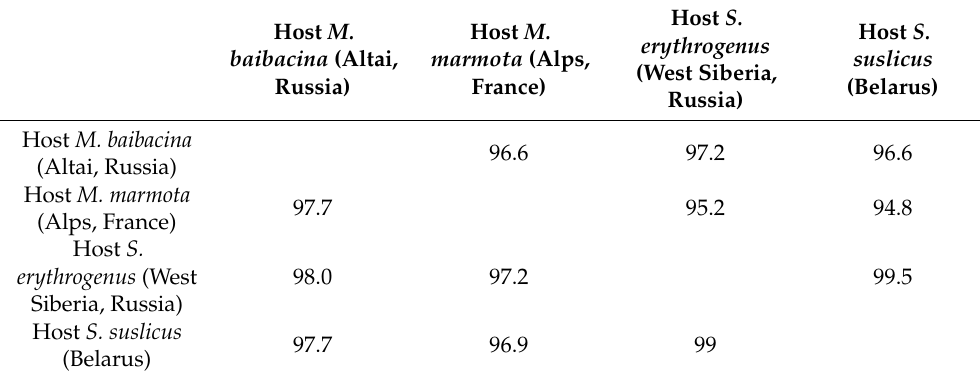
Table 3. Sequence identity rates (%) of mitochondrial genes cox1 (above the diagonal) and nad1 (below the diagonal) of Ctenotaenia marmotae from different host species. Host